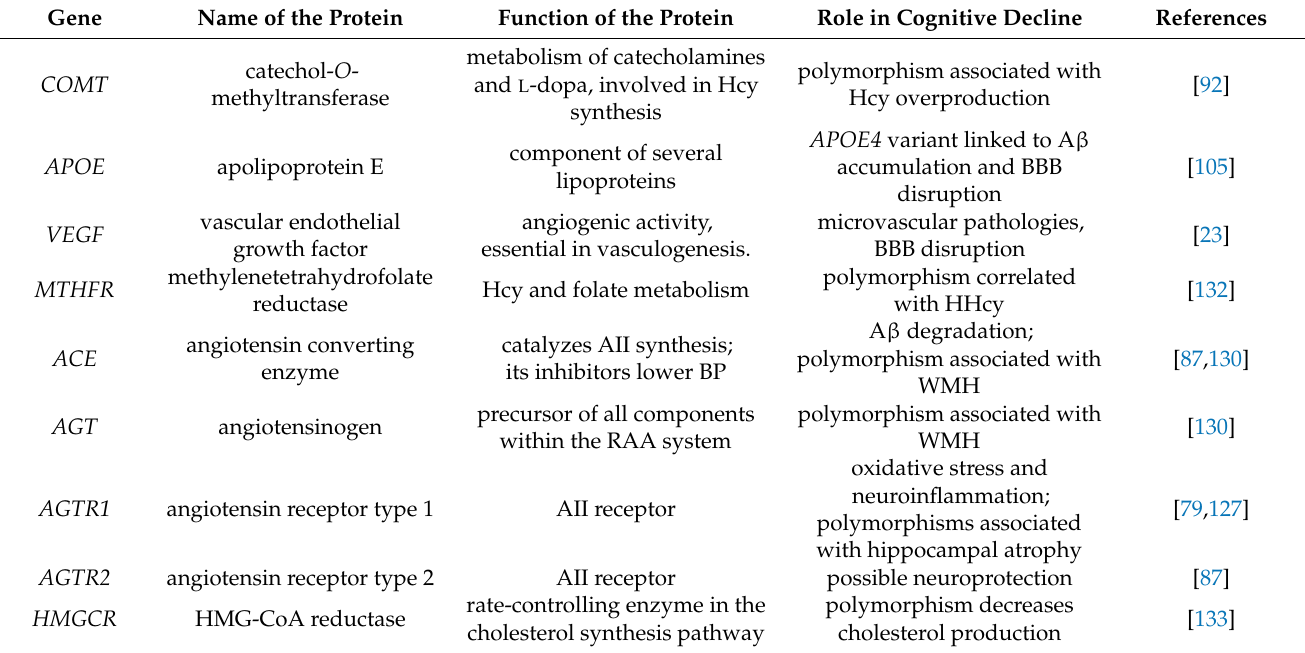
Table 2. Genetic factors influencing vascular functions and cognitive decline in